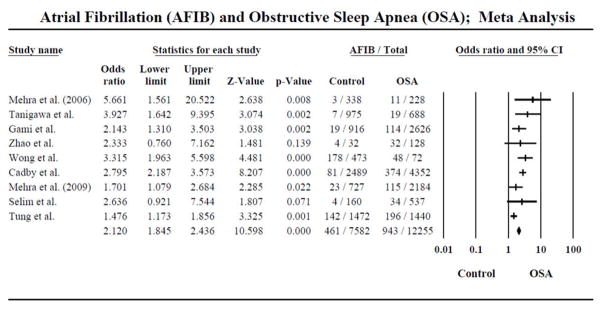
Forrest plot depicting the odds ratio of having AFIB associated with OSA.